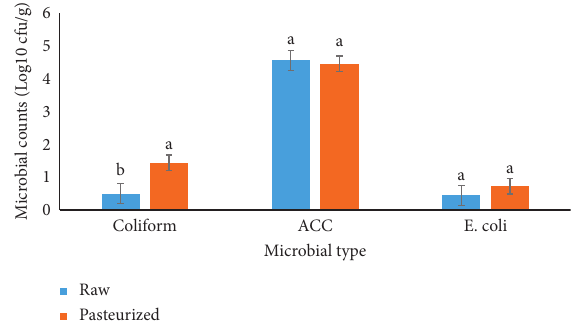
Figure 3: Microbial counts according to milk type. Different su- perscripts indicate a significant difference according to milk type ( P < 0 . 05). ACC: aerobic colony count; E coli : Escherichia coli